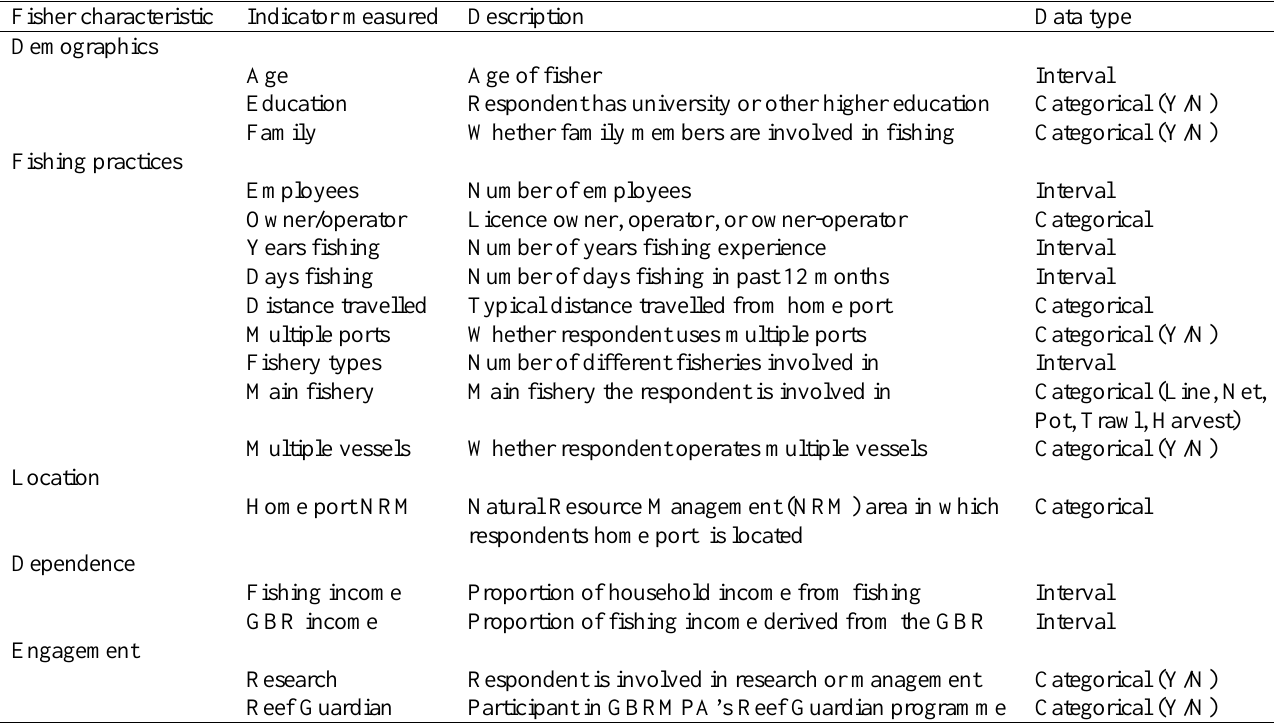
Table A1.1. Characteristics of commercial fishers measured in the survey